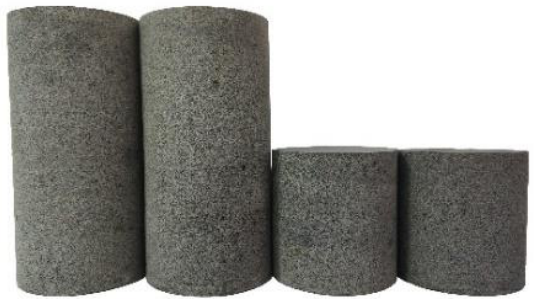
Figure 2. Coal measures sandstone specimens.